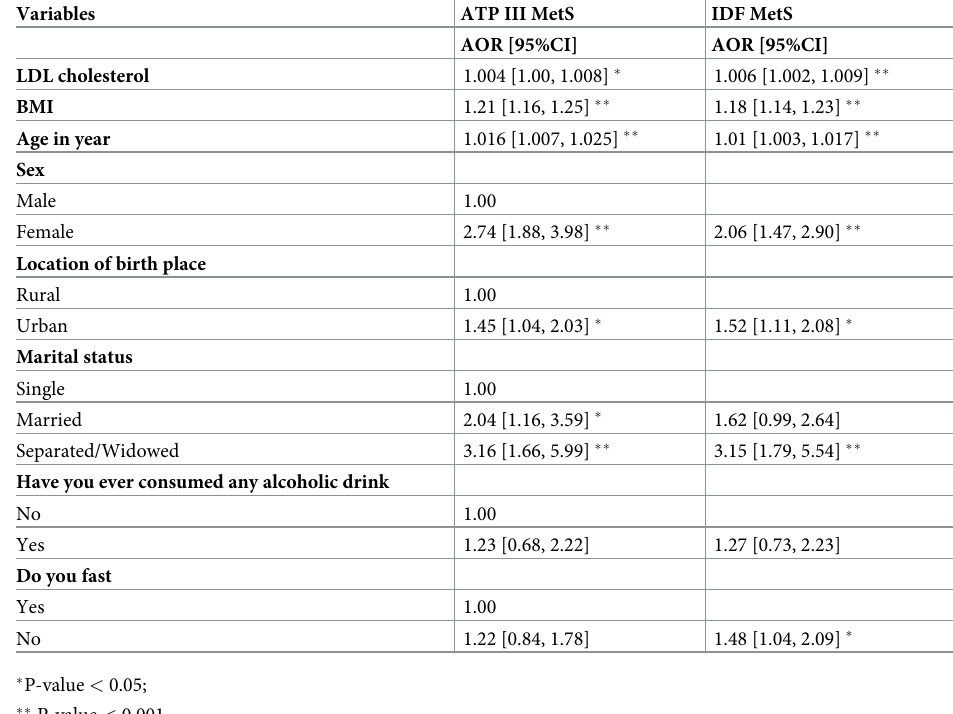
Table 3. Multivariable analysis of factors associated with metabolic syndrome by ATPIII and IDF classification in Gondar city, Northwest Ethiopia